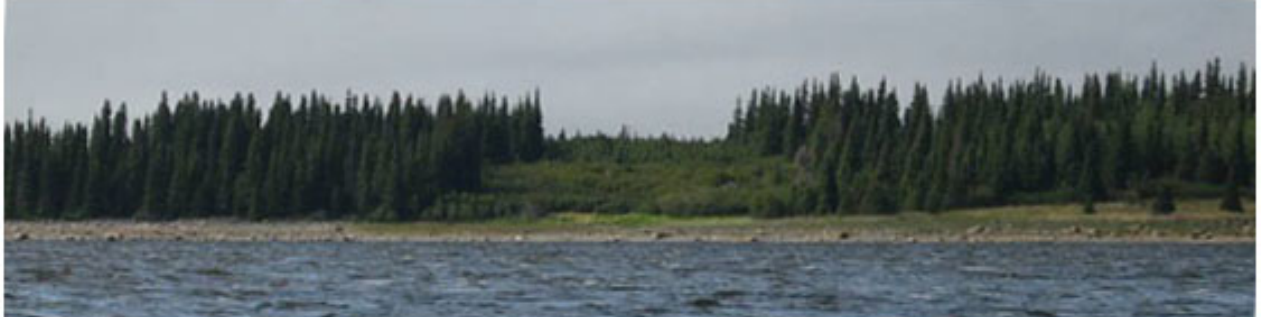
Fig. 5 . A small tuuhiikan , 55 to 70 meters wide and 100 meters long. It was first cut before 1958 and was last maintained (re-cut) in the late